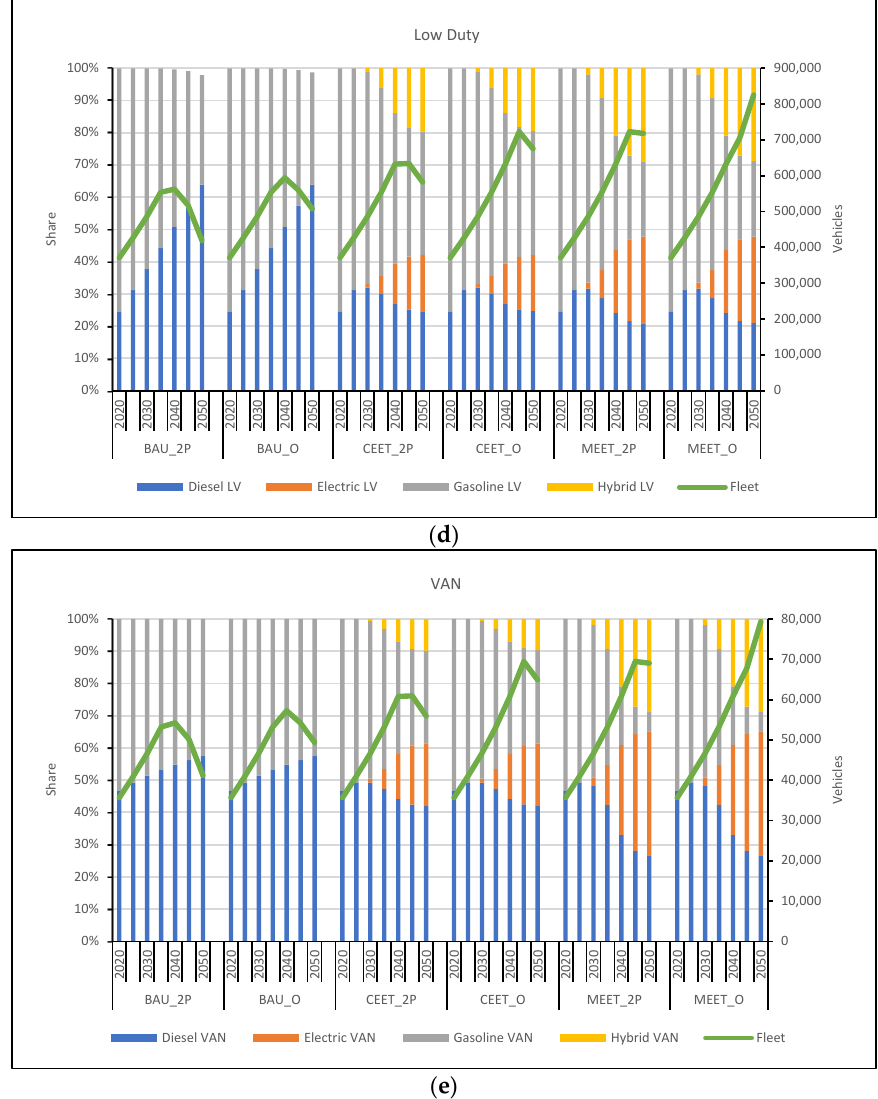
Figure 8. Evolution of Total Fleet and Technology share per scenario for ( a ) Households vehicles, ( b ) Bus ( c ) Heavy Duty, ( d ) Low Duty. ( e ) VAN